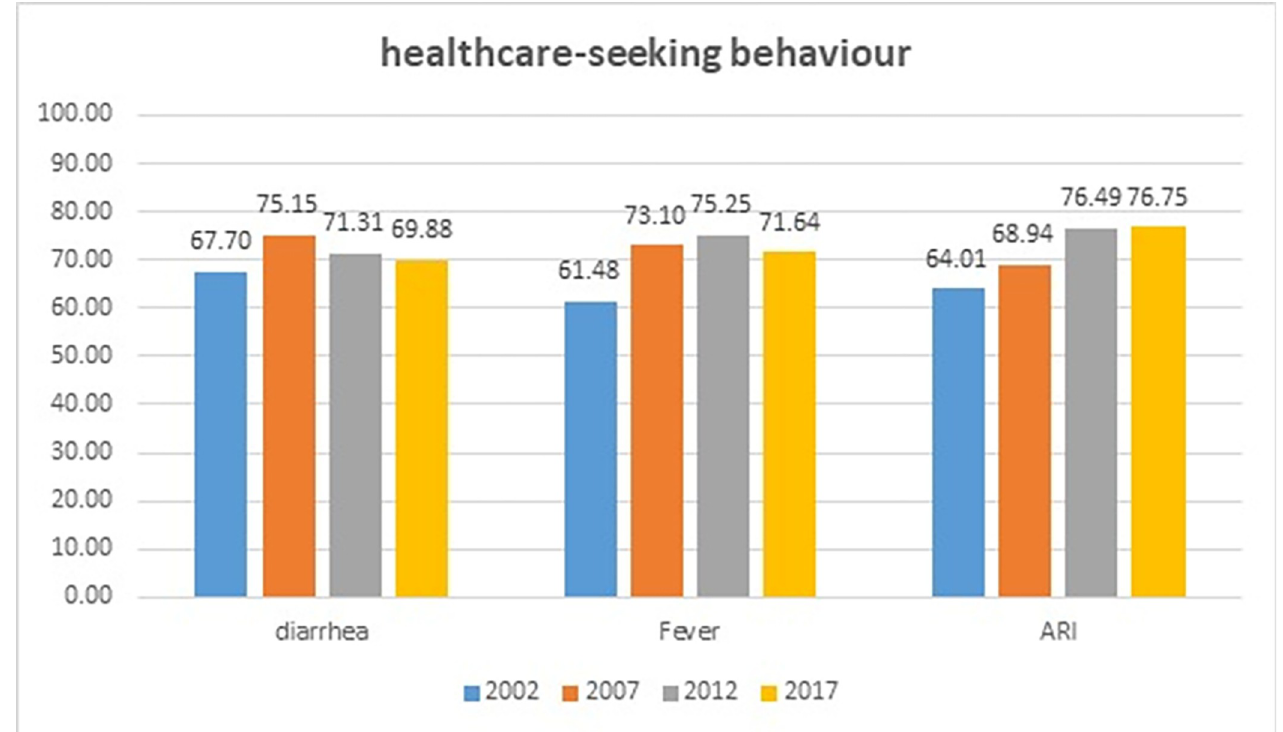
Fig 1. Mothers’ healthcare-seeking behavior for their children 0–59 months in Indonesia (prepared by the authors from the analysis of data).